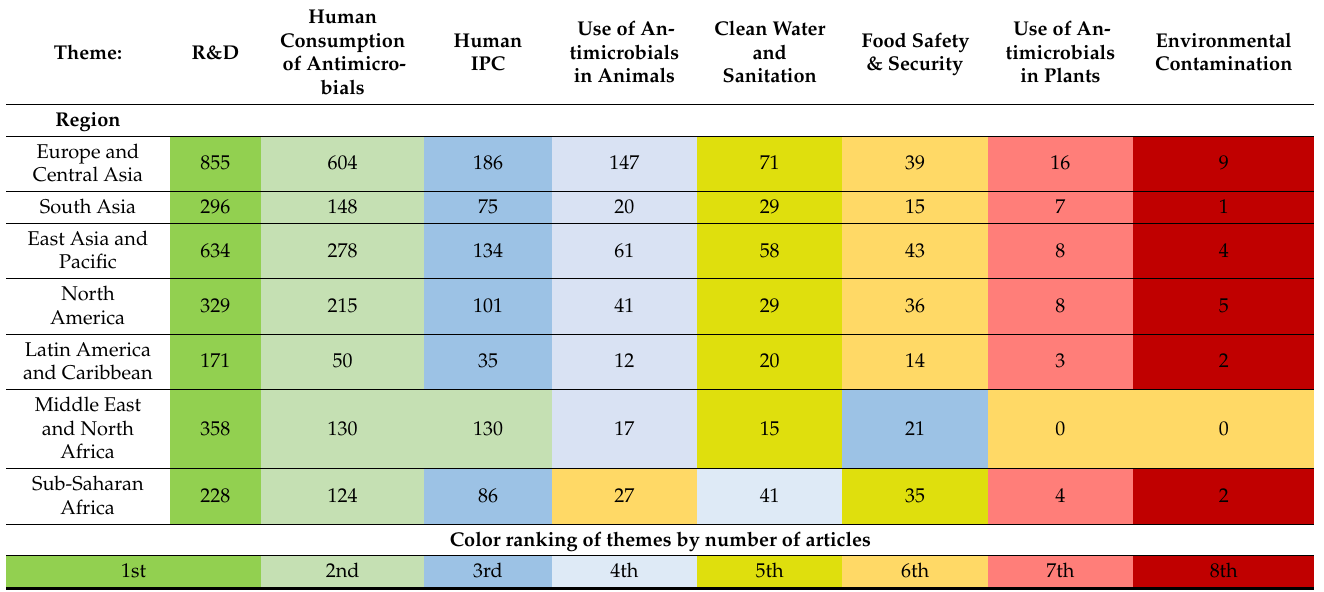
Table 5. AMR theme distribution of article records and ranking by regions ( n = 12,638).